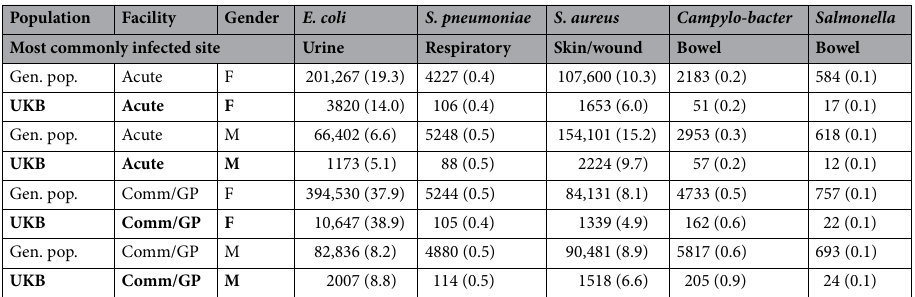
Table 3. Numbers of individuals and (in brackets) rate per 1000 persons years observed with isolation of various microorganisms. Numbers are presented stratified. Population refers to either the general population aged 40–69 during UK Biobank recruitment (Gen. Pop.), where the specimen was sent from (Facility = either Acute NHS Trusts, which contain inpatients (Acute) or from out of hospital settings (Community/General Practice (Comm/GP)).